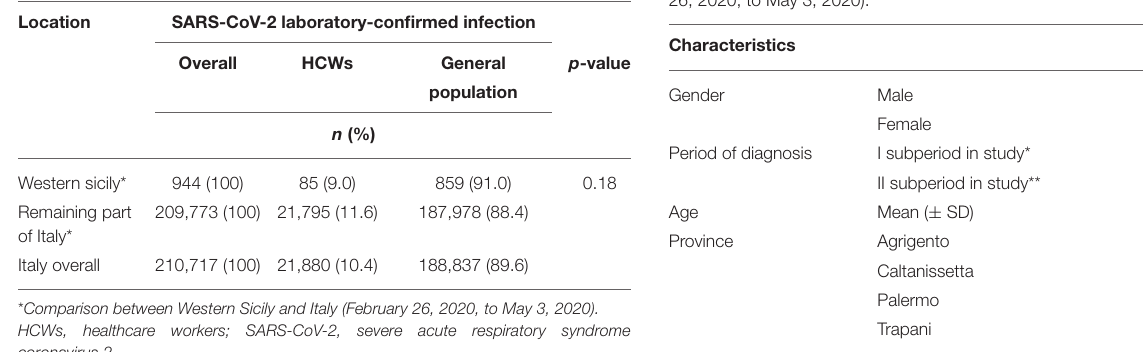
TABLE 2 | Characteristics of 85 HCWs with a laboratory-confirmed diagnosis of SARS-CoV-2 infection working in the western Sicilian healthcare context